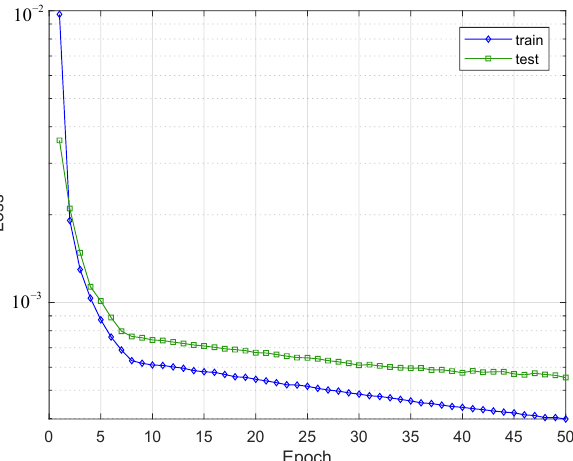
Figure 16. Changing of the loss value through the epocs in train and test sets of the GRU (250 Cells) + Dense